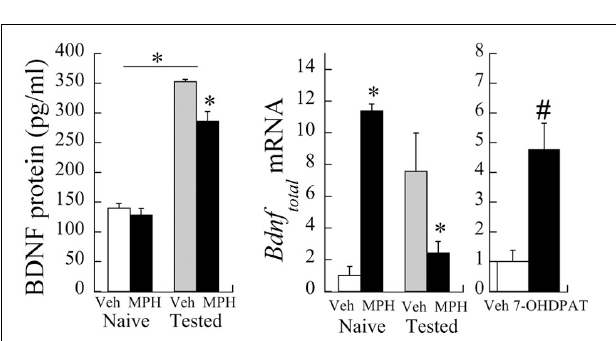
FIGURE 3 | Bdnf mRNA changes following juvenile MPH treatment between 20 and 35 days of age relative to controls. (left) Veh or MPH rats were assessed at P60 without prior cocaine place conditioning (naïve) or after place conditioning to 10mg/kg cocaine for 2 days (tested). ∗ p < 0 . 05. (right) A separate group of subjects was exposed to the D3R-preferring agonist ± 7-OHDPAT between P20-35 and assessed for Bdnf at P60. # p < 0 . 06 Mean ± SE for n = 6 subjects